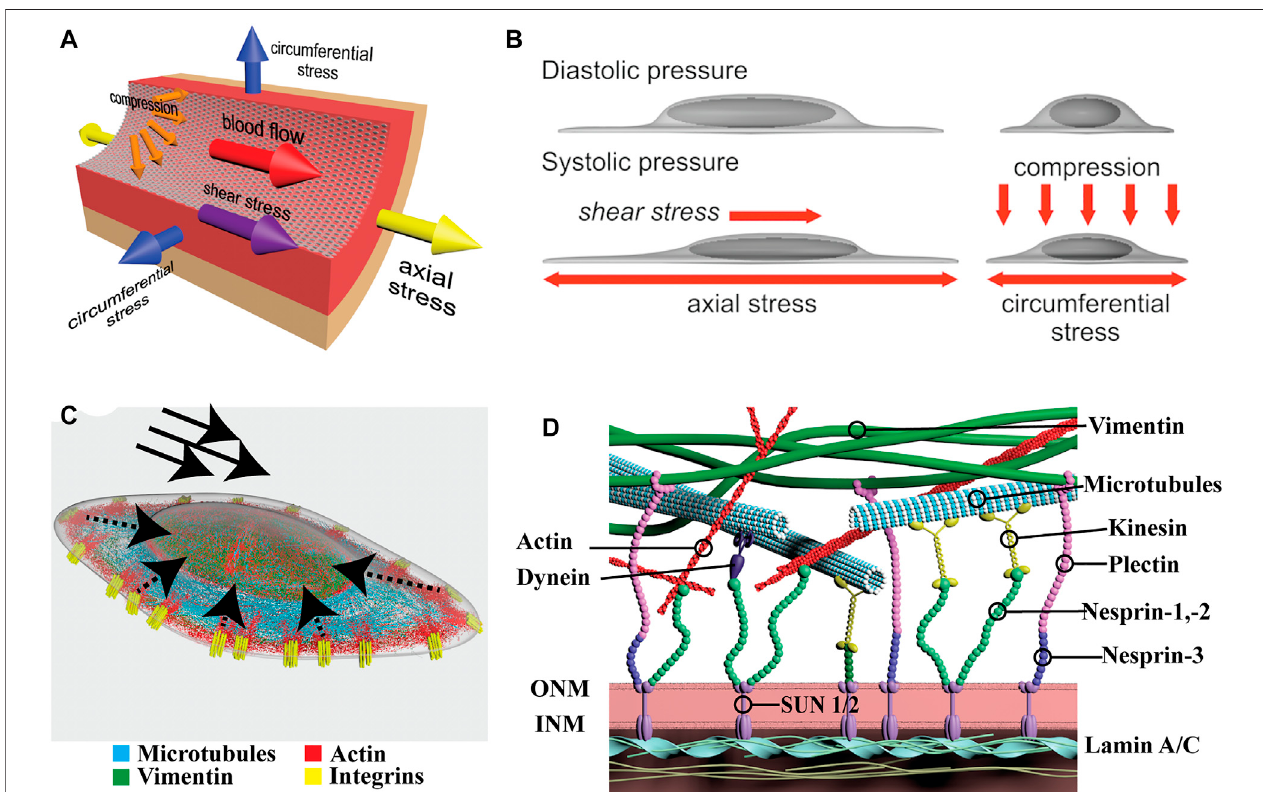
FIGURE 1 | Physical forces in vascular cells and organization of LINC proteins. (A) Schematic depicting the major forces present in a large vessel. Arrows indicate the directions of fl uid shear stress imposed by fl ow, and axial, circumferential, and compression stress imposed by distention of the vessel. (B) Depiction of nuclear and cytoplasmic changes in endothelial cells under shear stress (left) and compression (right). Note how the nucleus protrudes into the lumen of the vessel and it is directly exposedto fl ow. (C) Organizationofthemajorcytoskeletal fi lamentsinendothelialcells.Actin,inred,connectswithintegrins,inyellow,withinfocaladhesions(FAs). Dashed arrows indicate directions of force propagation from FAs to the nucleus. Solid arrows indicate the direction of shear stress. Microtubules (blue) extend throughout the cell and vimentin (green) forms a cage around the nucleus. (D) Closer look at the cytoskeletal connections to the LINC complex. The major cytoskeletal fi laments connect either directly or indirectly to nesprins. Nesprins anchored in the outer nuclear membrane (ONM) connect to SUN proteins in the perinuclear space. Finally, SUN1/2 proteins at the inner nuclear membrane (INM) connect to the nuclear Lamins which themselves make contact with chromatin.